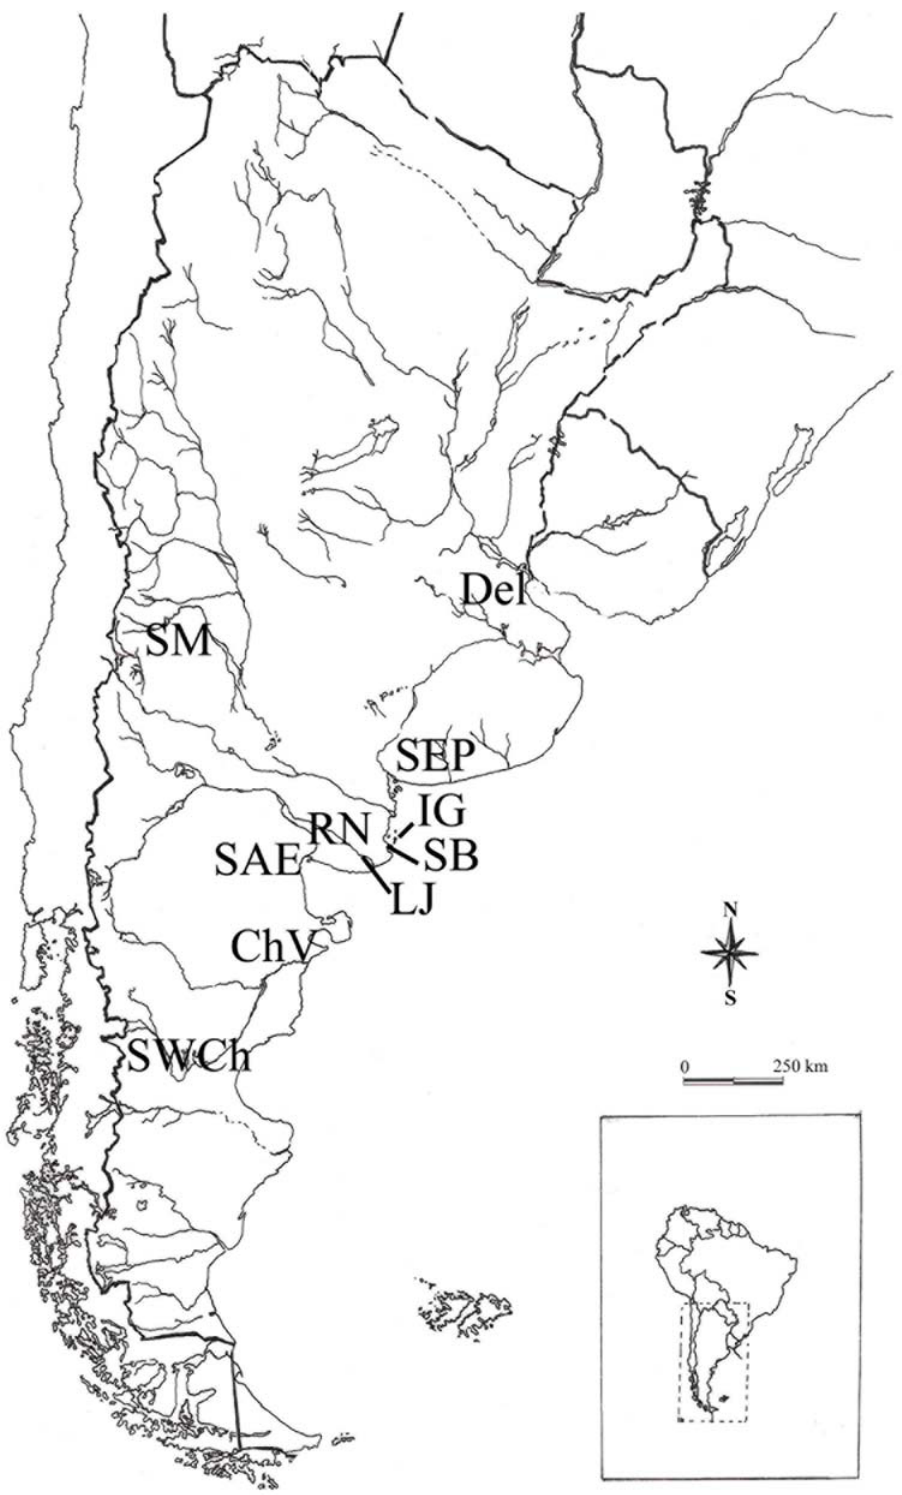
Figure 1. Map showing geographic location of the crania samples analyzed. doi:10.1371/journal.pone.0005746.g001 In geometric morphometrics, shape variation can be defined as the information that remains in the coordinates of landmarks and semilandmarks after the differences due to location, scale and